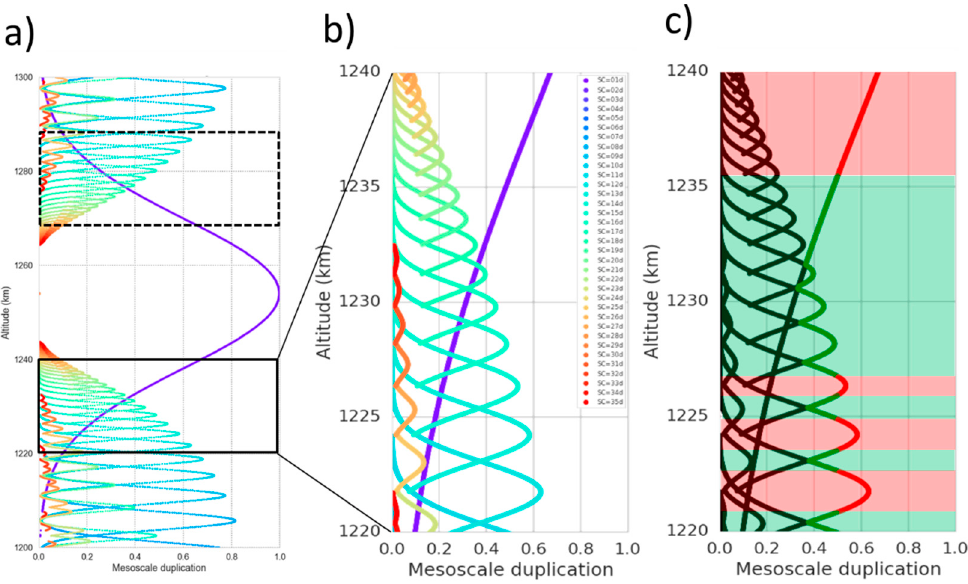
Figure 12. Same as Figure 10a from 1200 to 1300 km (panel ( a )) and near 1230 km (panel ( b )). In panel ( c ), we separate favorable (green) from undesirable (red) altitudes by looking at the maximal correlation of each orbit sub-cycle for the altitude range of panel ( b ). The altitude range in panel ( b ) and panel ( c ) corresponds to the plain rectangle of panel ( a ) and where the longest valid altitude range was found.